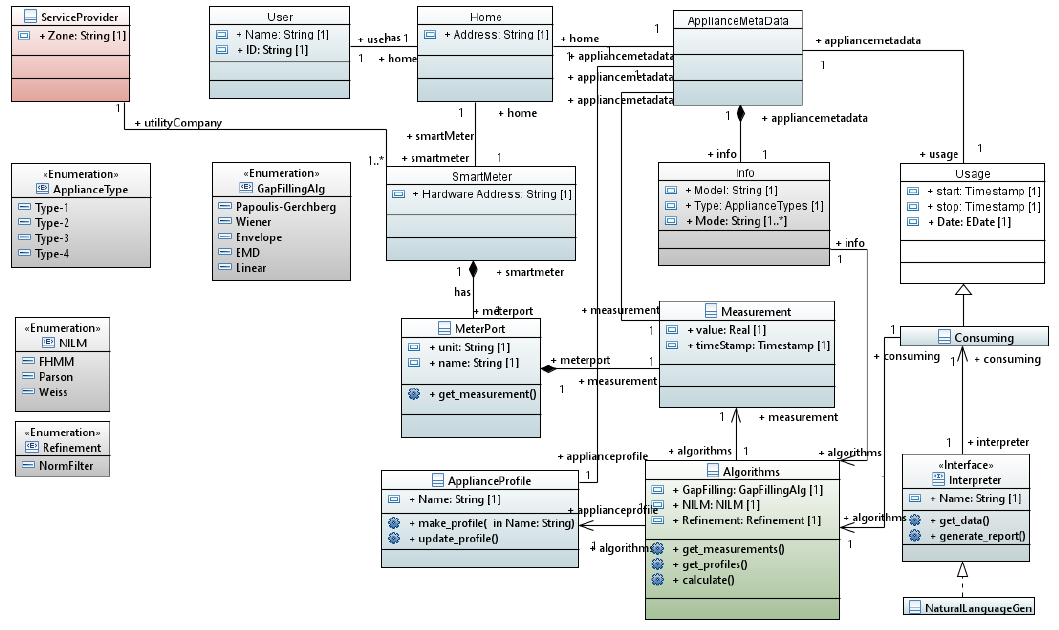
Figure 5. UML class diagram of the framework